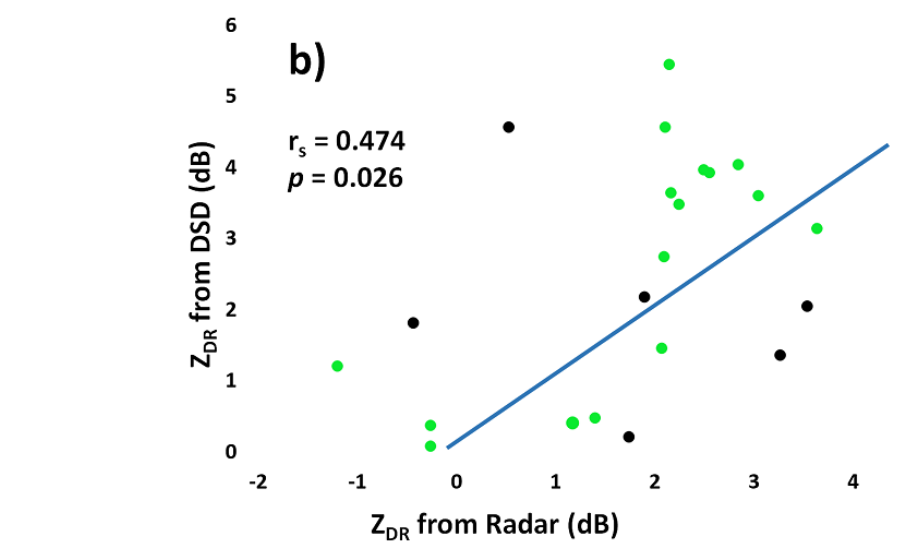
Figure 4. As in Figure 3, except for a differential reflectivity (Z DR ) comparison between radar and disdrometer datasets. Blue line in ( a ) is broken when no precipitation was recorded by the disdrometer. In ( b ), black dots are from the leading convective cell and green dots are from the supercell. Spearman’s correlation (r s ) is indicated along with its p -value for all points. The Z DR distribution was also compared in the supercell’s Z DR arc region. The Z DR arc was